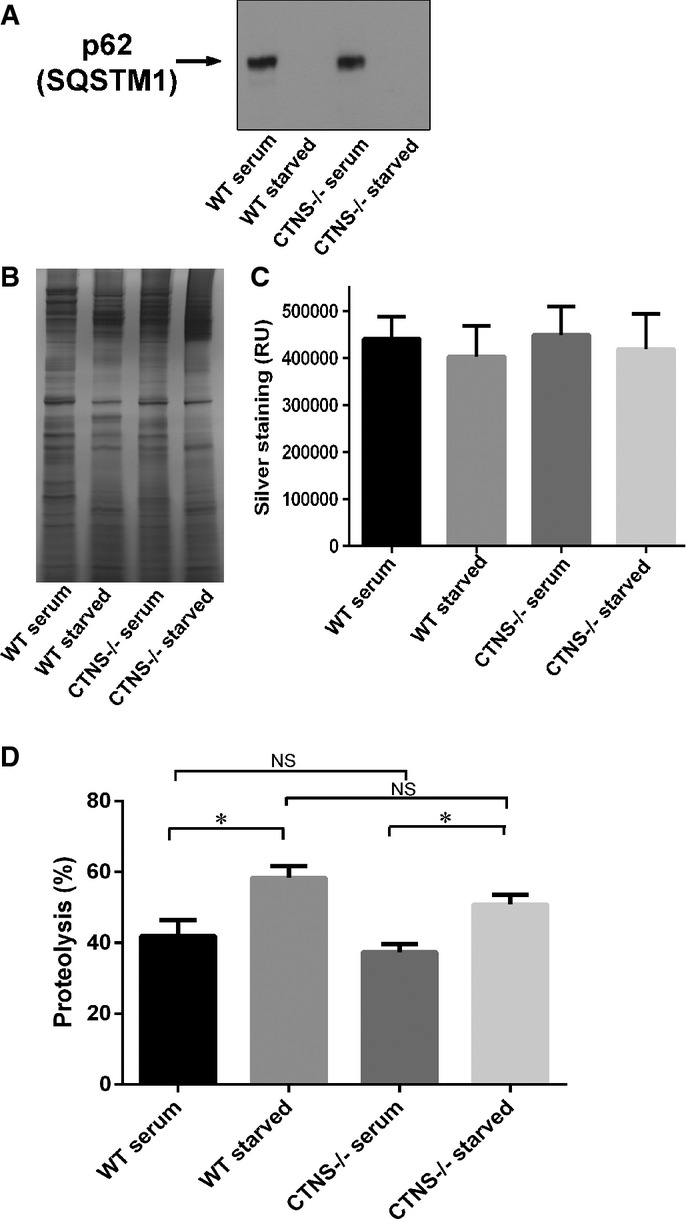
Degradation of SQSTM1/p62 and long-lived proteins is not impaired in CTNS-deficient cells
Analysis of the expression of endogenous SQSTM1 in wild-type or Ctns−/− mouse fibroblasts under fed (serum) or starved (15 h serum starvation) conditions. In these assays, 20 μg of total protein lysates were resolved by SDS-PAGE and analyzed by Western blot (WB; A). Equal loading was established by silver staining (B). Quantification (mean ± SEM) of five different areas of each silver-stained lane are shown in (C).

Degradation of long-lived proteins using metabolic labeling was performed as described in Supplementary Materials and Methods. The data represent the mean ± SEM of nine independent samples analyzed in three independent experiments. *P = 0.009 for WT and *P = 0.0013 for Ctns−/−, respectively. NS, not significant (unpaired t-test).
Source data are available online for this figure.